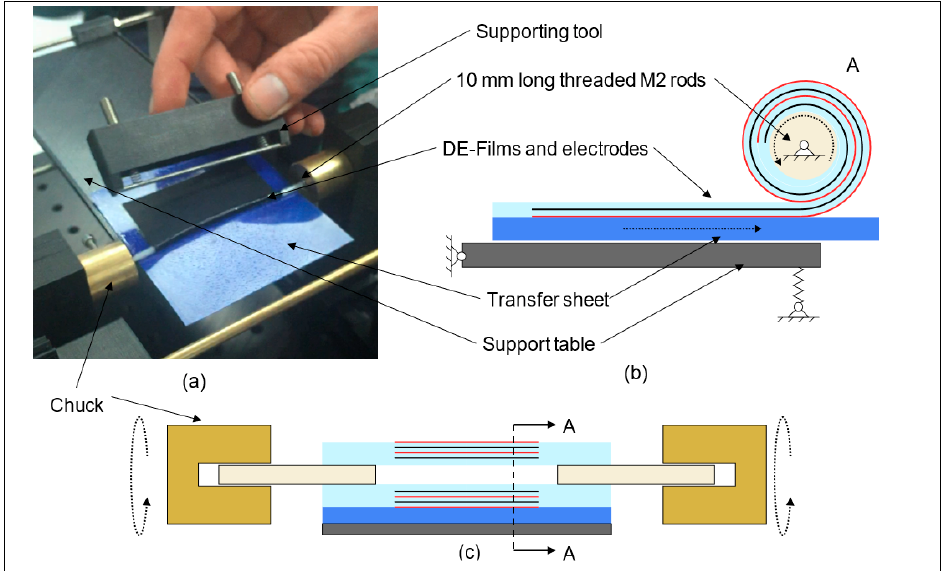
Figure 5. Picture ( a ) and schematic ( b , c ) of the rolling process according to our previous work. The cross ‐ sectional view is shown in ( b ) and longitudinal cut in ( c ). Note the hollow section in the middle of the roll, which is not supported during the rolling process, and also decreases the utilization of the available volume.